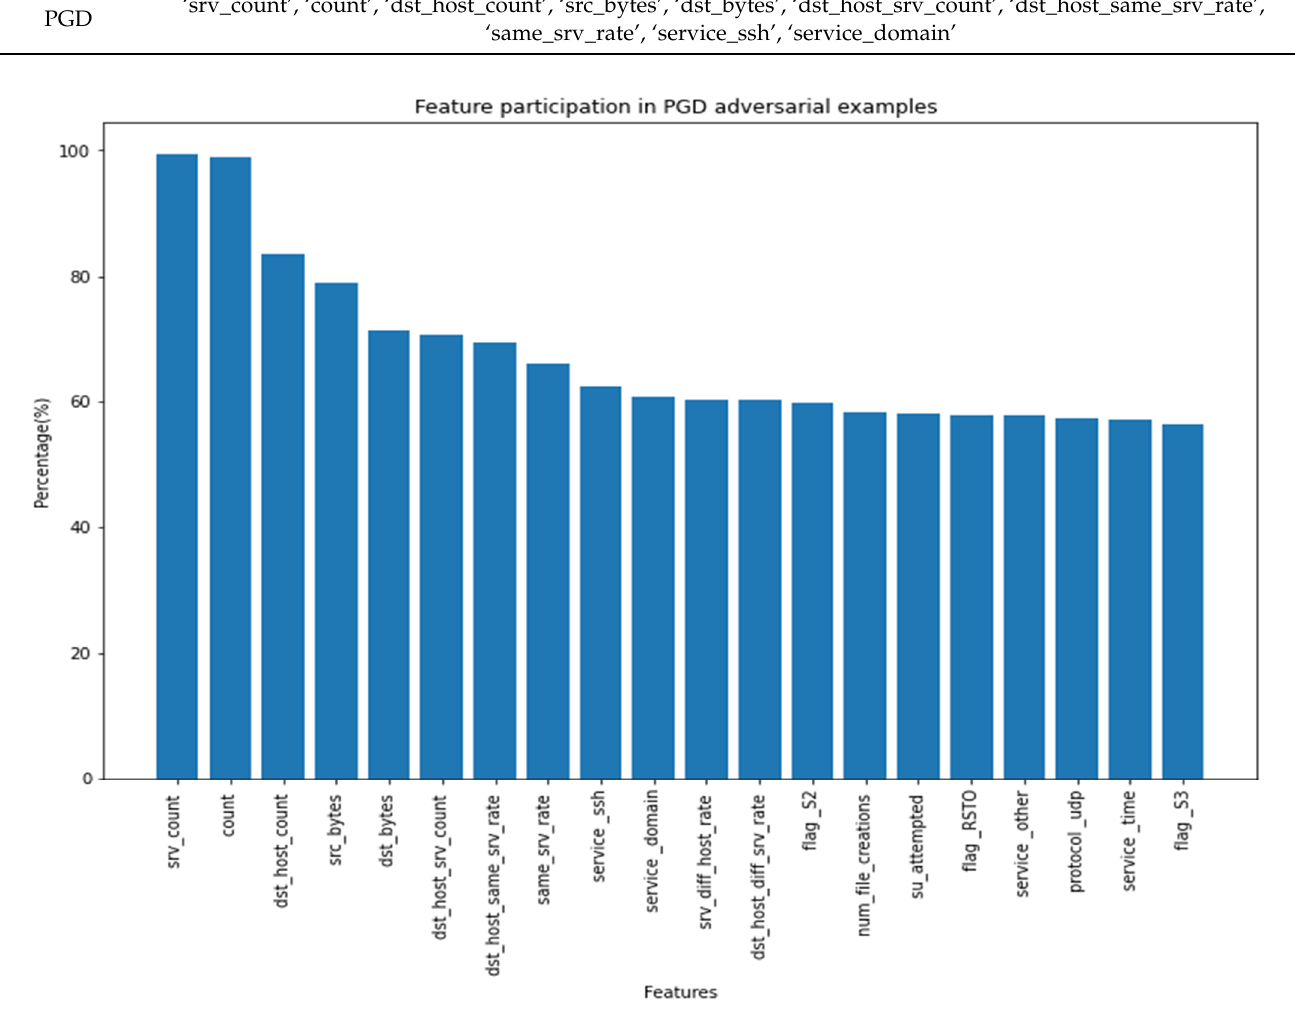
Figure 8. Feature participation in PGD adversarial examples.